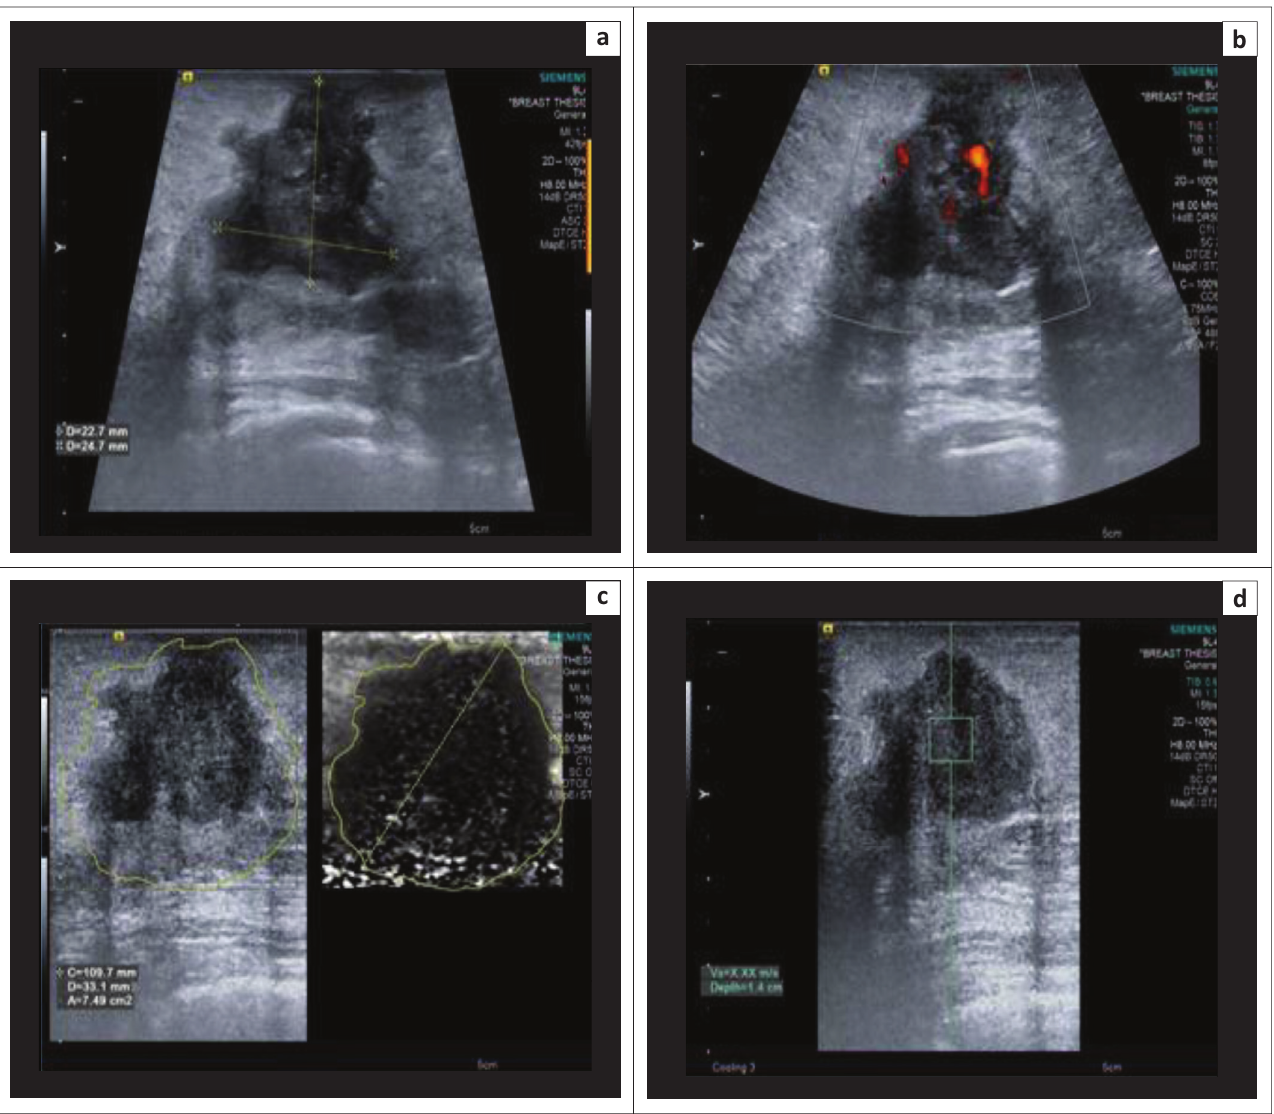
FIGURE 5: (a, b) Greyscale image showing a classical Breast Imaging Reporting and Data System 5 lesion – an irregular, spiculated, taller than wide lesion with a colour Doppler image showing internal vascularity; (c) elastogram showing a hard lesion (grey to black) with a larger area of the lesion on elastogram as compared to B-mode ultrasonography; (d) shear wave velocity in the lesion – X.XX m/s. The final histopathology report was infiltrating ductal